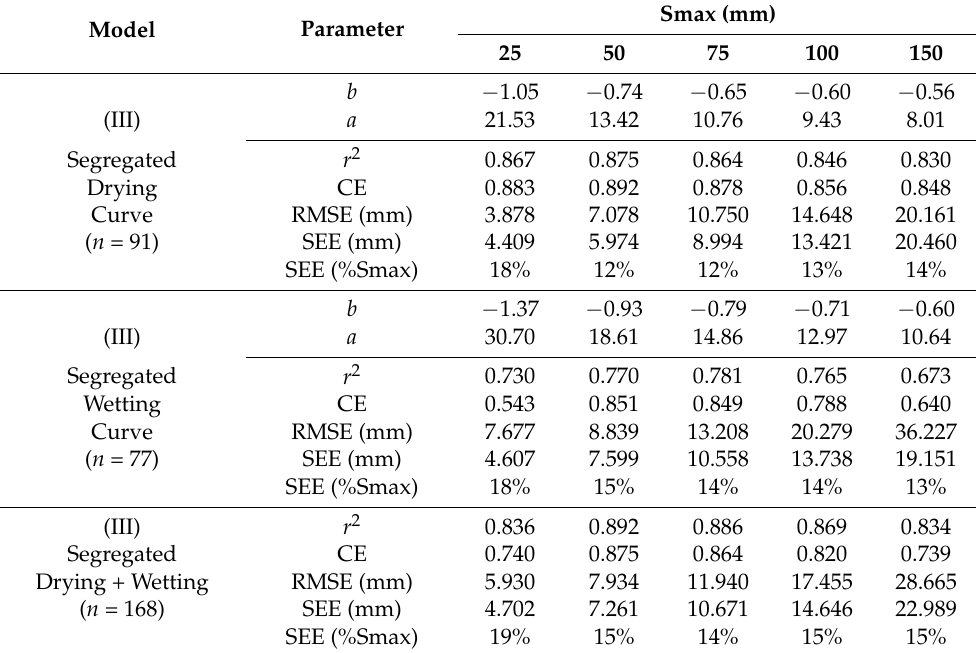
Table 3. Regression parameters and performance indicators of the logistic model applied to the segregated data series with different soil water storage capacities, Smax: segregated model (III) considering the drying and wetting subsets independently and merged (SM, %, independent variable; S , mm, dependent